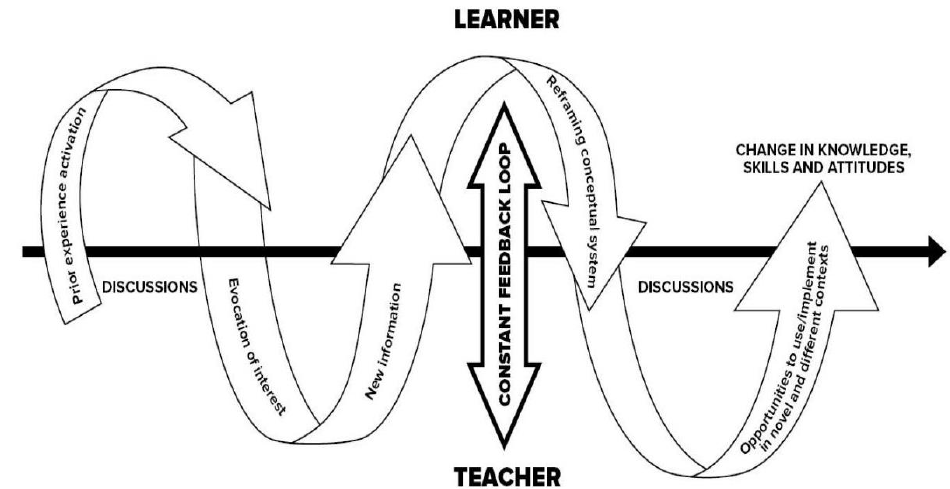
Figure 2. The explanatory model of an instructionally guided learning process. Source: created by the authors based on conceptual change theory (e.g., Vosniadou 2007).